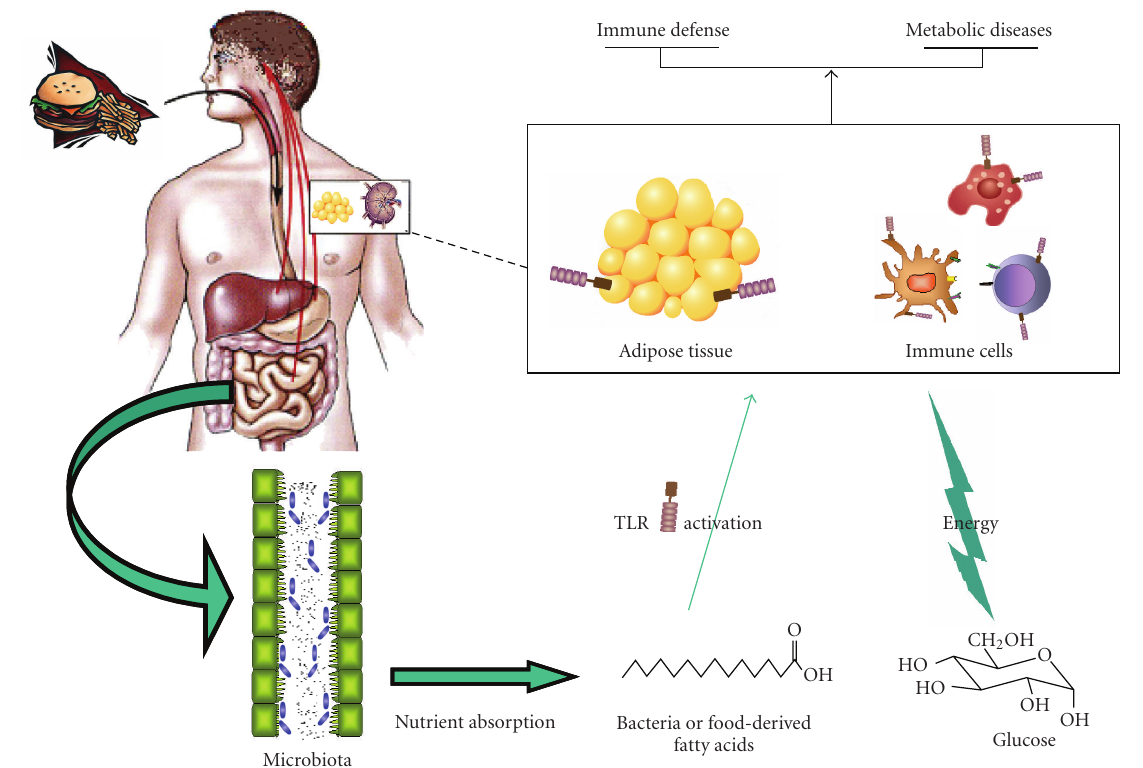
Figure 1: After a meal, fatty acids and glucose, through intestinal absorption, enter the blood. Both serve as fuels for cells or tissues, glucose being the most important to fulfill the energy requirement of immune cells, and lipids representing major components of cell membranes. Besides, food-derived fatty acids, as well as intestinal bacteria-derived fatty acids could be sensed by Toll-like receptors (TLRs) which are expressed on immune cells, adipocytes or intestinal gut, resulting in activation of the immune system. Depending on the intensity, the time lasting, and the control of these events, it will either favor the development of an e ffi cient immune defense, or lead to a drift towards metabolic diseases such as